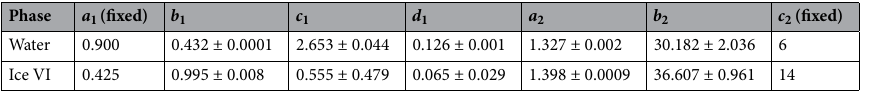
Table 1. Fitting parameters of power-law and Murnaghan-type models for the refractive index of water (0.05–1.29 GPa) and ice VI (1.17–2.21 GPa). The subscripts 1 and 2 refer to power-law and Murnaghan-type models, respectively.